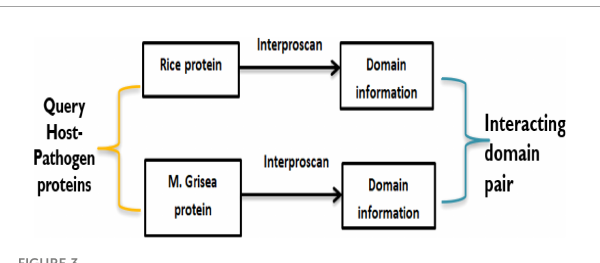
FIGURE 3 A schematic illustration showing a domain – domain method for